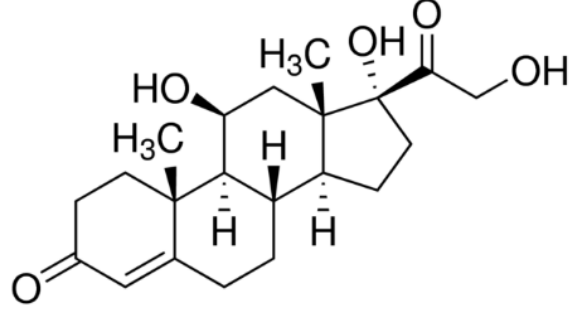
Figure 1. Semi-developed cortisol